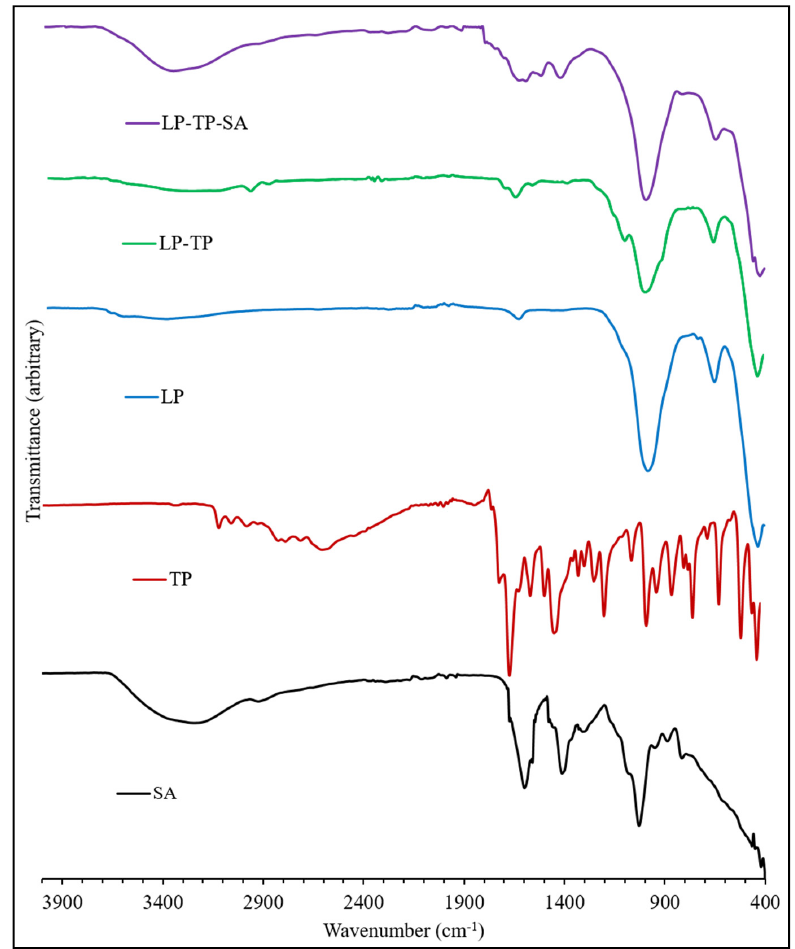
Figure 8. ATR-FTIR spectra of TP, LP, LP-TP and LP-TP-SA.